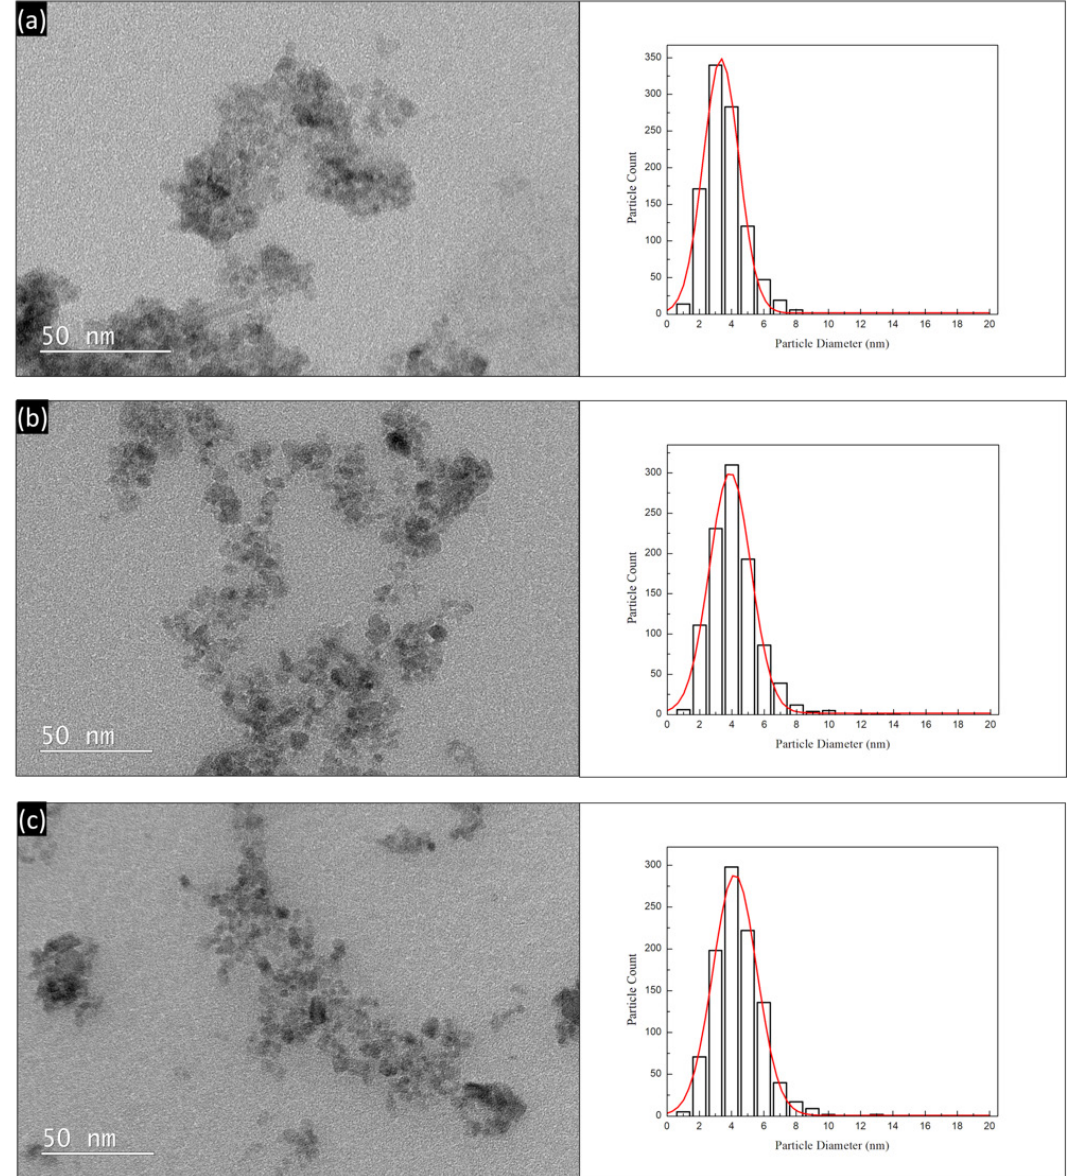
Fig. 3. TEM bright field micrographs (left) and size distribution histograms with Gaussian distributions in red (right) of the L-glutamic acid series of capped nanoparticles, being PreE (a), SimE (b) and PostE